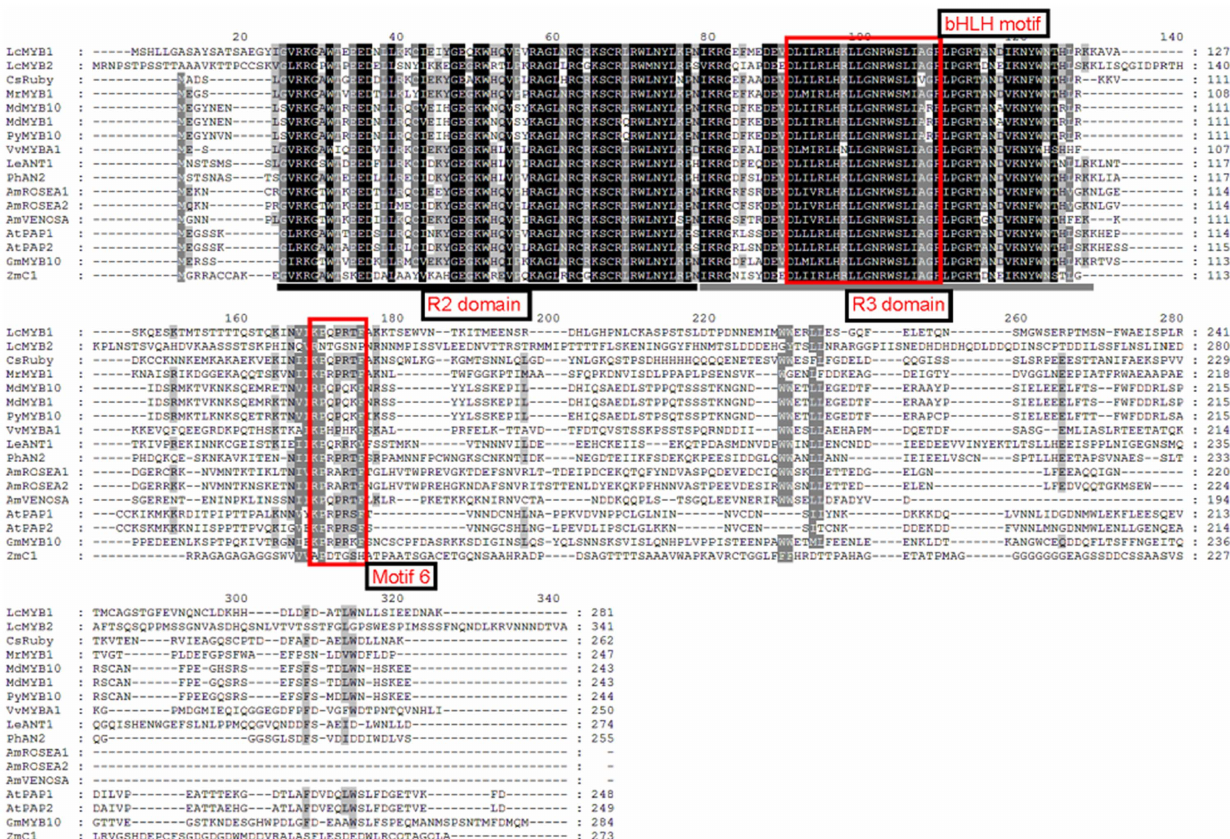
Figure 1. Protein sequence alignment of the R2R3 DNA-binding domains of LcMYB1 and the other known anthocyanin MYB regulators in other species. The R2 and R3 domains are underlined. The bHLH-binding motif is boxed in the R3 domain. Motif 6 was previously identified in the C-terminal domain of anthocyanin-related MYBs in Arabidopsis [39]. The accession number of these proteins (or translated products) are as follows in the GenBank database: MrMYB1 , GQ340767; MdMYB1 , ABK58136; MdMYB10 , DQ267896; PyMYB10 , ADN26574; GmMYB10 , ACM62751.1; PhAN2 , AAF66727; LeANT1 , AAQ55181; CsRuby , AFB73909; MrMYB1 , GQ340767; VlMYBA1 -1, BAC07537; VvMYBA1 , BAD18977; VvMYBA2 , BAD18978; GhMYB10 , CAD87010; AtPAP1 , AAG42001; AtPAP2 , AAG42002; AtMYB113 , NP_176811; AtMYB114 , NP_176812; AmROSEA1 , ABB83826; AmROSEA2 , DQ275530; AmVENOSA , DQ275531; and FaMYB1 , AF401220.